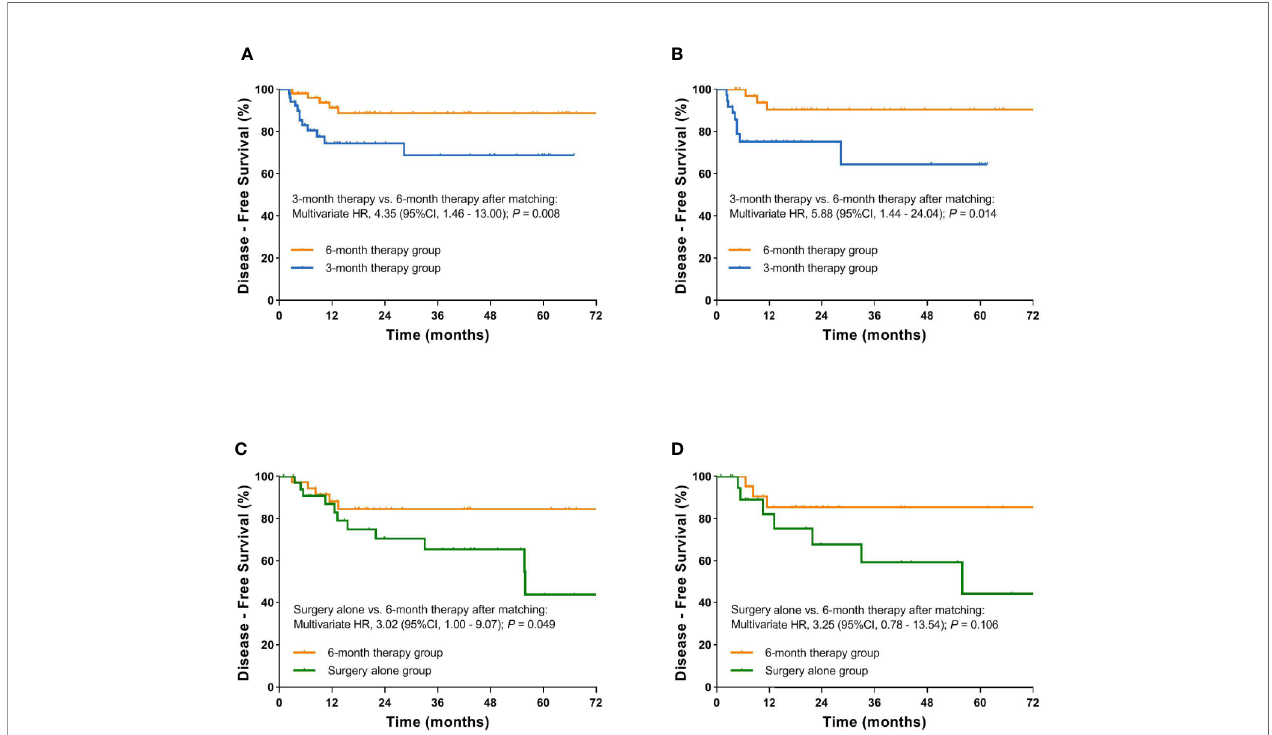
FIGURE 4 | (A) Kaplan-Meier curve of disease-free survival comparing 3-month therapy group and 6-month therapy group after propensity score matching; (B) Kaplan-Meier curve of disease-free survival comparing 3-month therapy group and 6-month therapy group for patients with stage III after propensity score matching; (C) Kaplan-Meier curve of disease-free survival comparing surgery alone group and 6-month therapy group after propensity score matching; (D) Kaplan- Meier curve of disease-free survival comparing surgery alone and 6-month therapy group for patients with stage III after propensity score